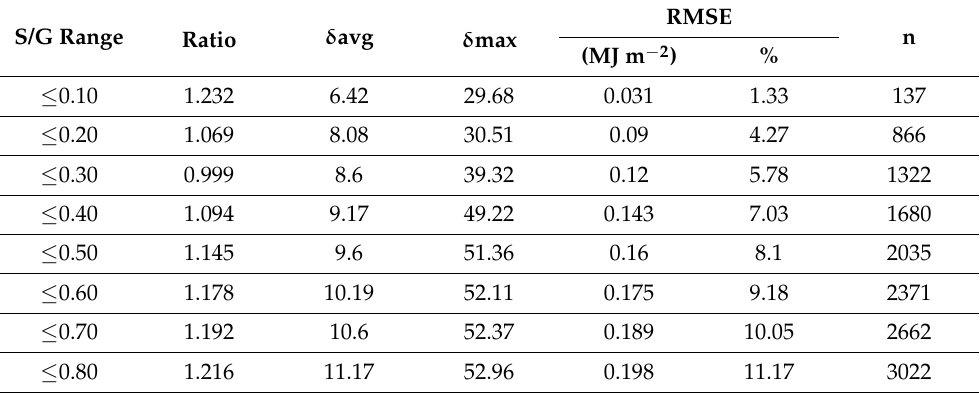
Table 3. The ratio between the calculated G at the TOA and I 0 , relative error ( δ avg, δ max) and RMSE (MJ m − 2 and %) between calculated and measured G at the